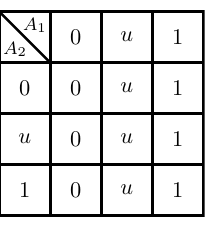
Figure 4. Alternative Kleene encoding representation.